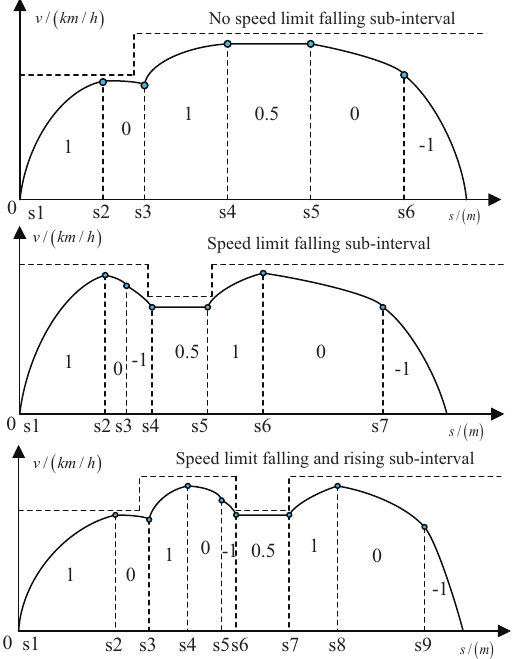
Figure 7. Coding of three speed limit